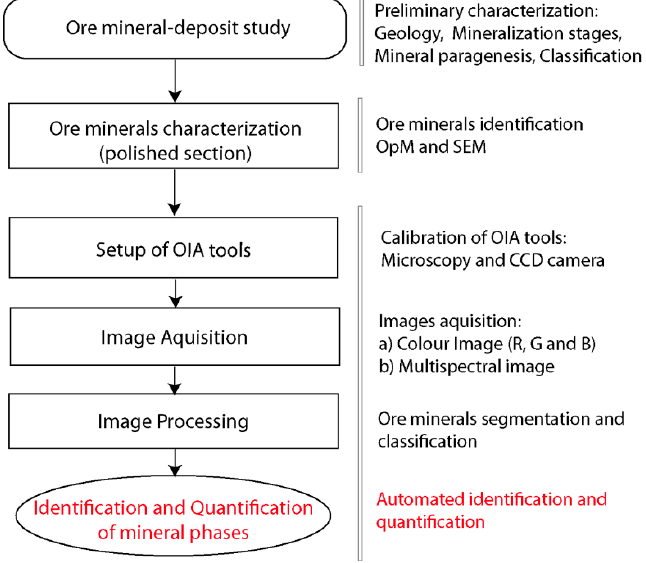
Figure 2. Schematic representation of the sequence of ore mineral identification and quantification using OIA. Based on [6].